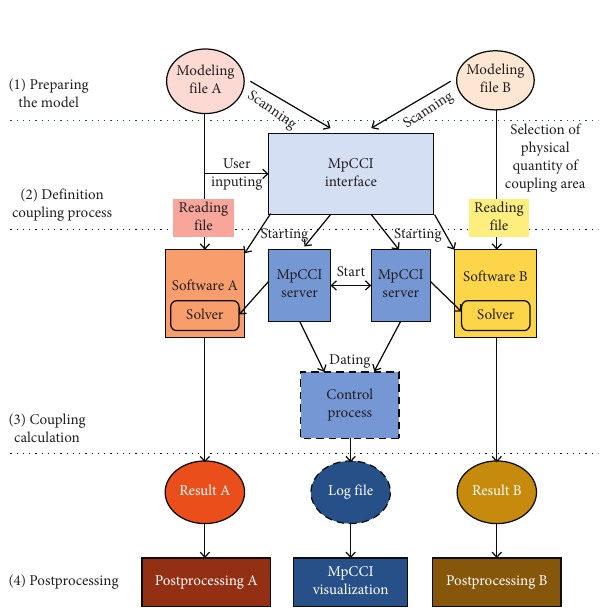
Figure 7: Interpolation of MpCCI.